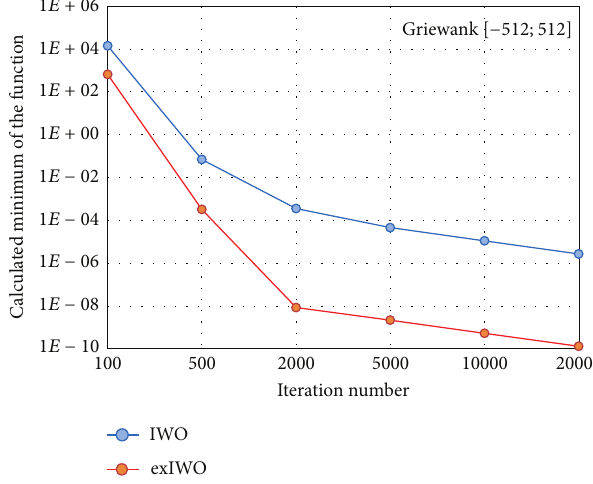
Figure 12: Averaged minima of IWO and exIWO for the 30- dimensional Griewank function.